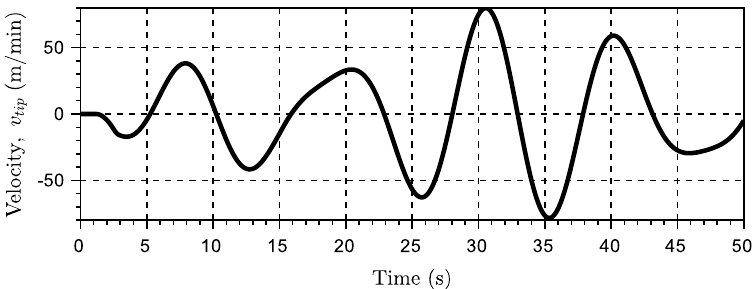
Figure 6. Velocity reference (the first 10 s are neglected due to the model initialization).